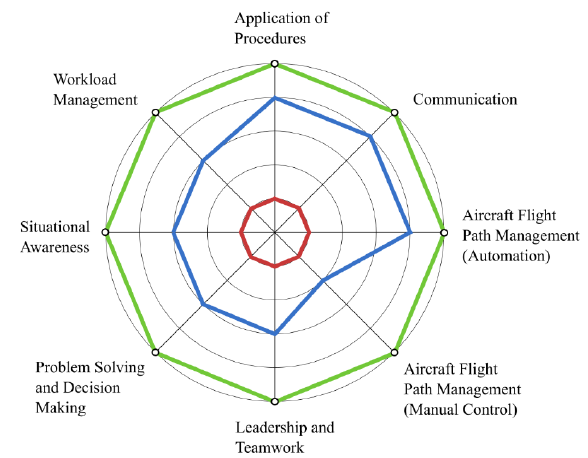
Figure 2. Graphic representation of grades by core